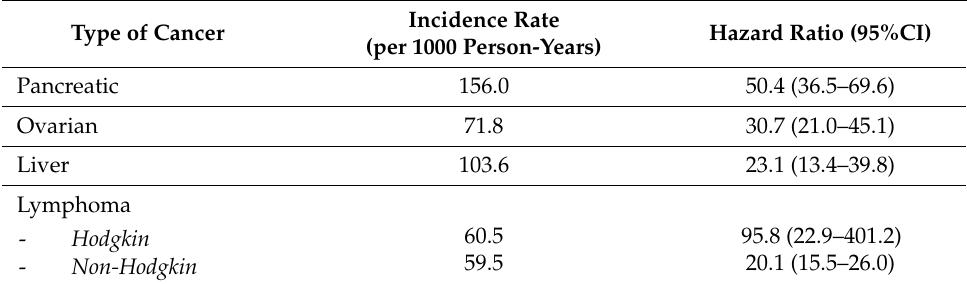
Table 4. Risk of venous thrombosis according to cancer type